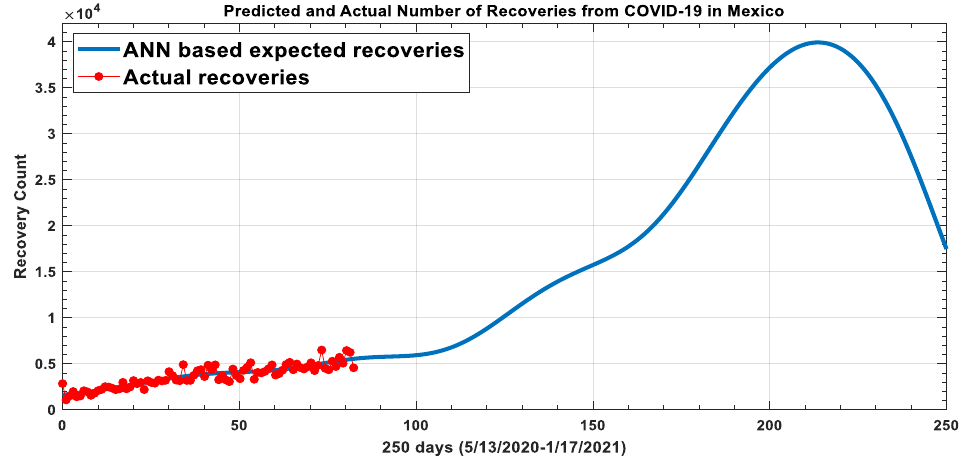
Figure 8. The training data and predicted data of COVID-19 recovered people in Mexico.